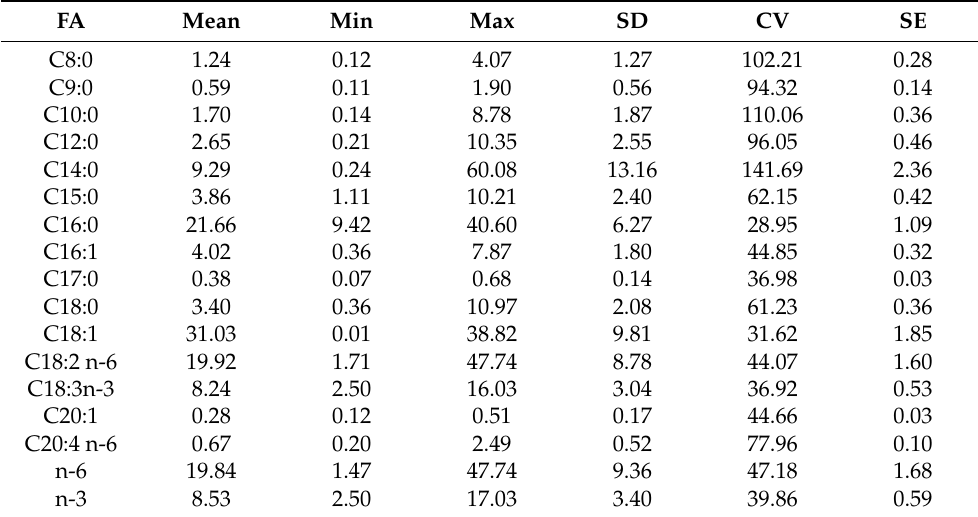
Table 2. The fatty acid composition of mare’s milk (g/100 g total fatty